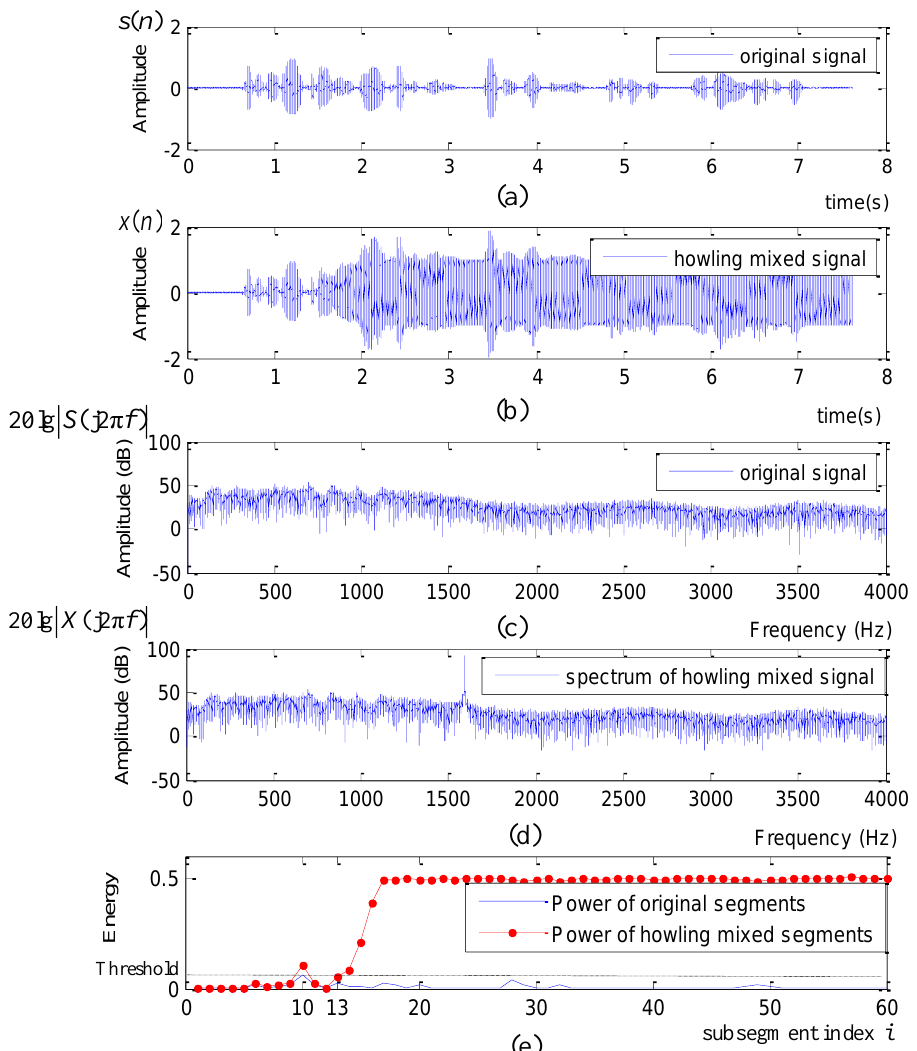
Figure 11. Energy Detector: ( a ) The original signal waveform; ( b ) The howling mixed signal wave- form; ( c ) The spectrum of the original signal; ( d ) The spectrum of the howling mixed signal; ( e ) The energy distribution of the original signal and the howling mixed